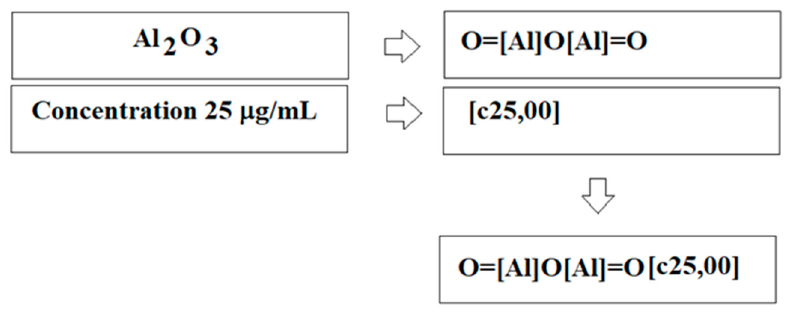
Figure 2. The scheme of building up quasi-SMILES for the situation where the impact of nano-oxide of aluminium in concentration 25 mg/mL is examined.